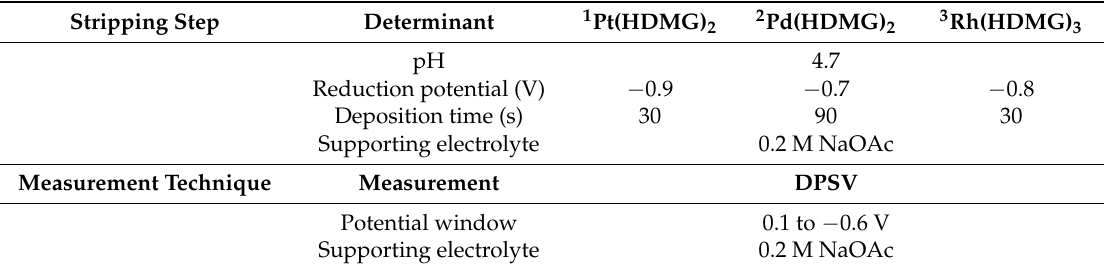
Table 3. Summary of the DPAdSV optimum conditions for the determination of Pt(II), Pd(II), and Rh(III)